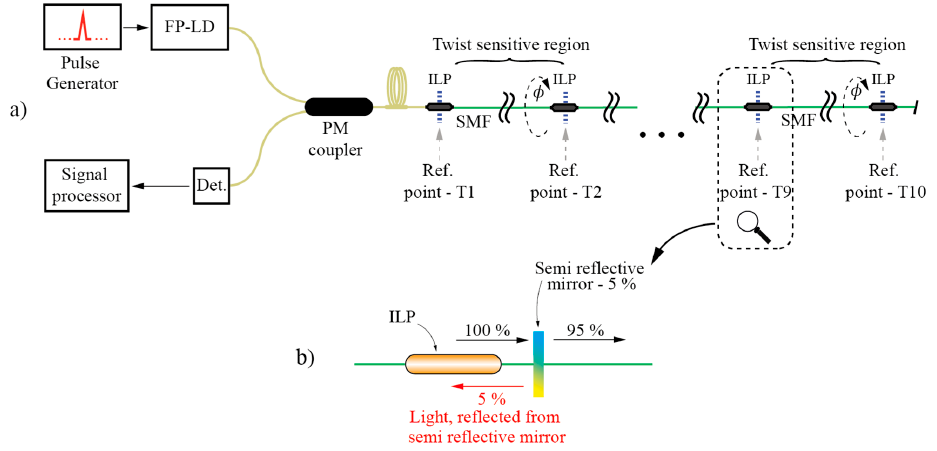
Figure 18. ( a ) A quasi-distributed sensor array for twist/rotation setup; and ( b ) ILP with a semi-reflective mirror setup.